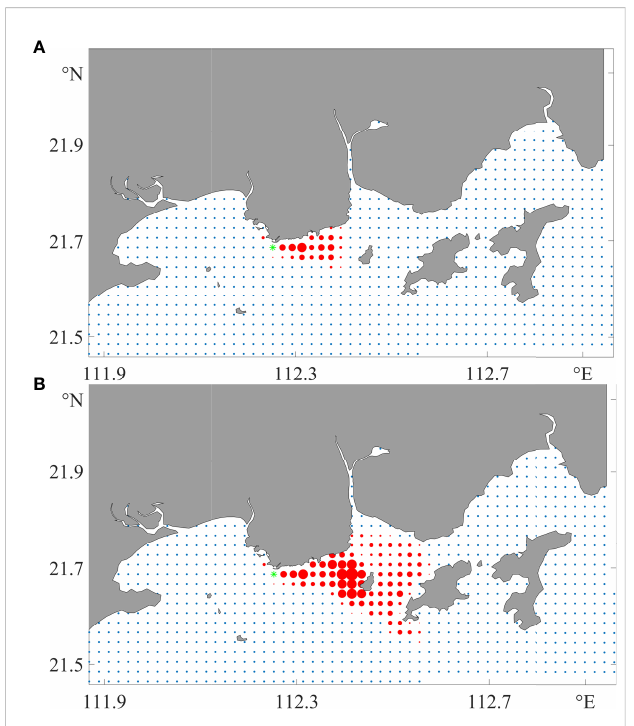
FIGURE 8 Potential source of Acetes near the nuclear power plant. (A, B) Results within 30 days (A) and 90 days (B) .